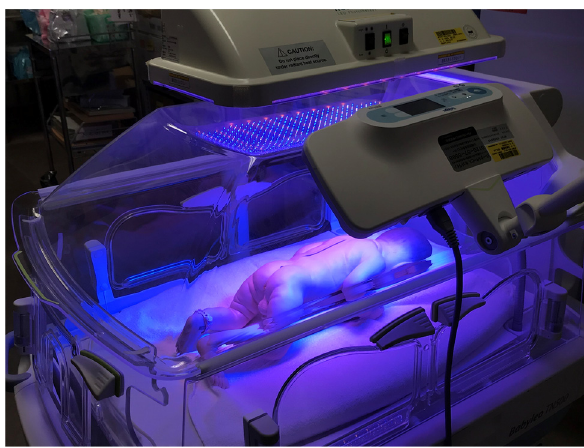
Figure 1: Schematic for double - LED phototherapy. Double - LED phototherapy is performed from above the incubator using neoBLUE and diagonally above the incubator using BiliLux. Before starting treatment, it is important to adjust the device ’ s position so that the baby is in the center of the irradiation fi eld to measure the illumi - nance on the baby ’ s body